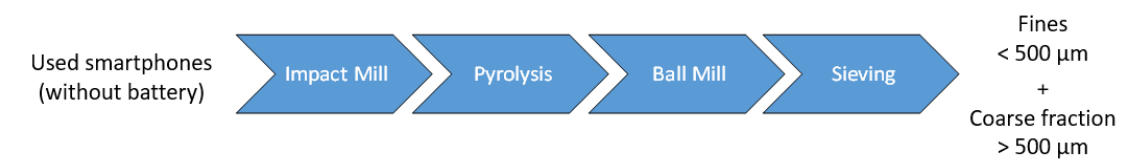
Figure 1. Process chain for the production of a gallium-rich fraction from used smartphones [4].